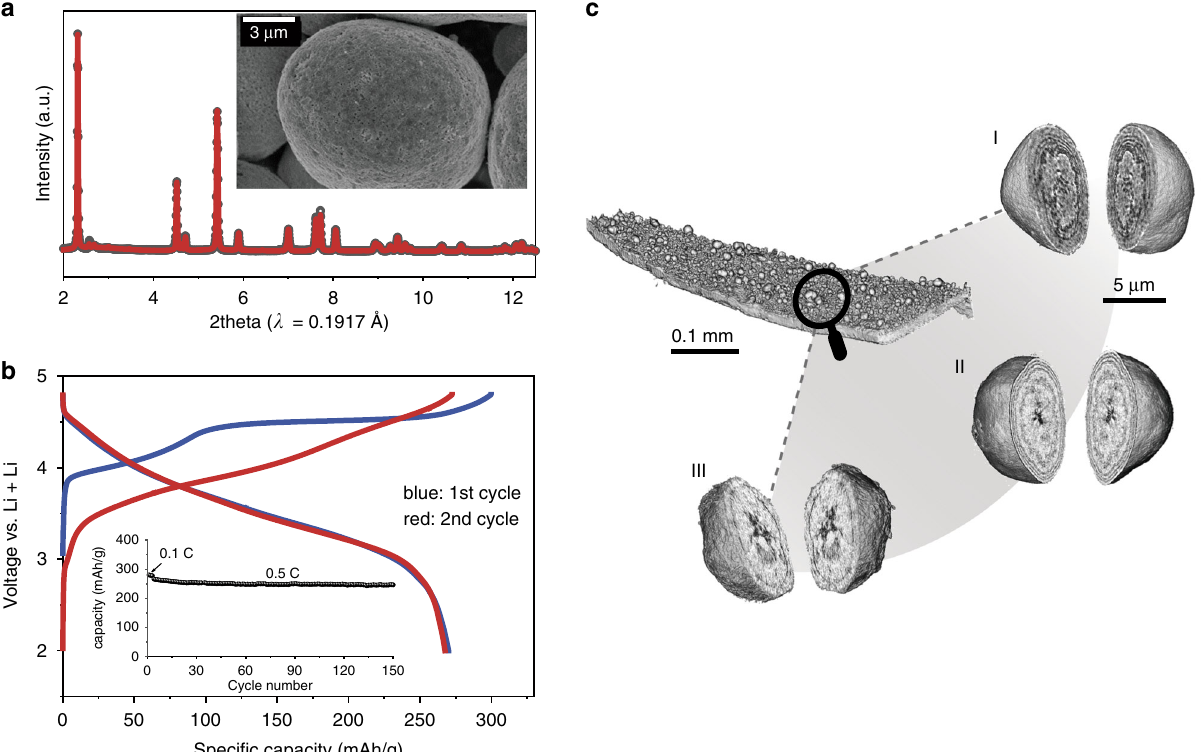
Fig. 1 Electrochemical performance and morphology of LirNMC. a Structural characterization of LirNMC cathode material by XRD and Rietveld re fi nement. The inset graph shows the SEM image of LirNMC particles. b Charge-discharge pro fi le and electrochemical cycling data of LirNMC| |Li metal half-cell. c Three-dimensional rendering of the composite electrode and magni fi ed views of a few arbitrarily selected LirNMC cathodes particles (panels I, II, and III). The mesoscale core/multi-shell separation is clear visible in all the